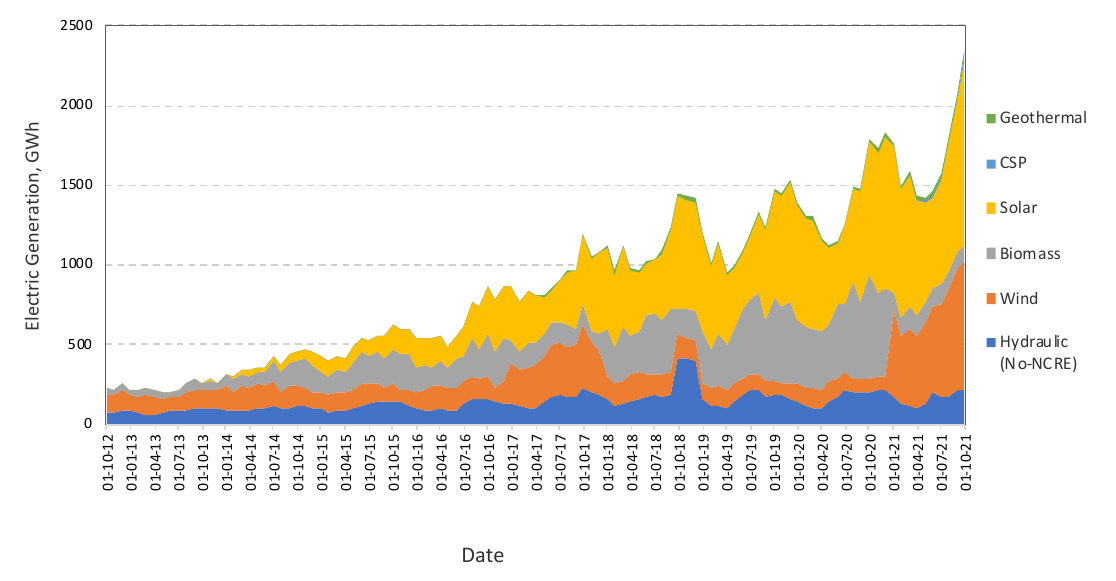
Figure 1. Monthly electricity generation, obtained from NCRE in Chile (2012–2021), Source: Energía Abierta, 2021 [10].